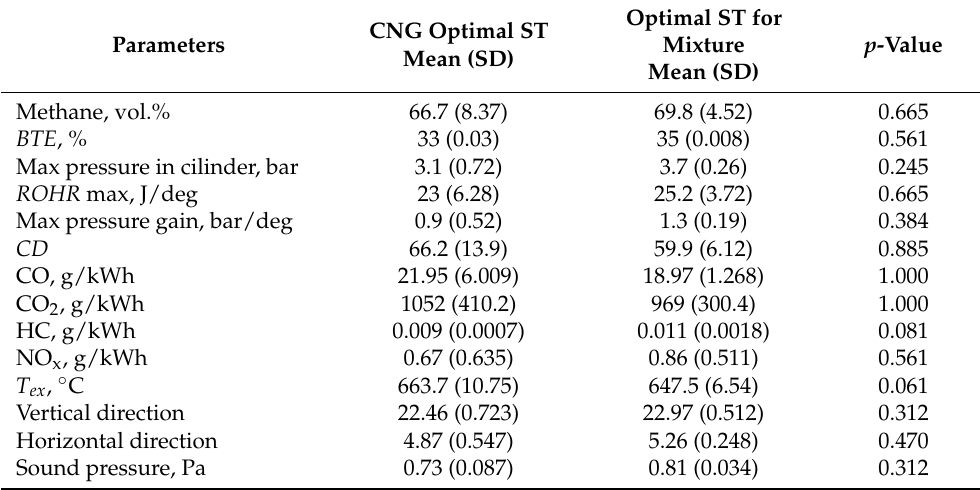
Table 8. Comparison of vibration, sound pressure and emission parameters between angles